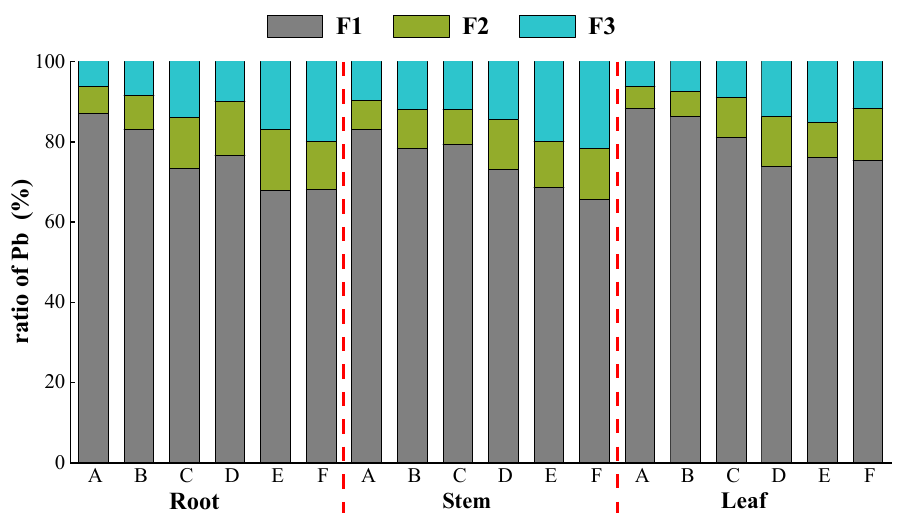
Figure 3. Distribution of Pb in different subcellular organs of K. paniculata. Note: F1 represents cell wall content fraction, F2 represents organelle content fraction, and F3 represents soluble component content